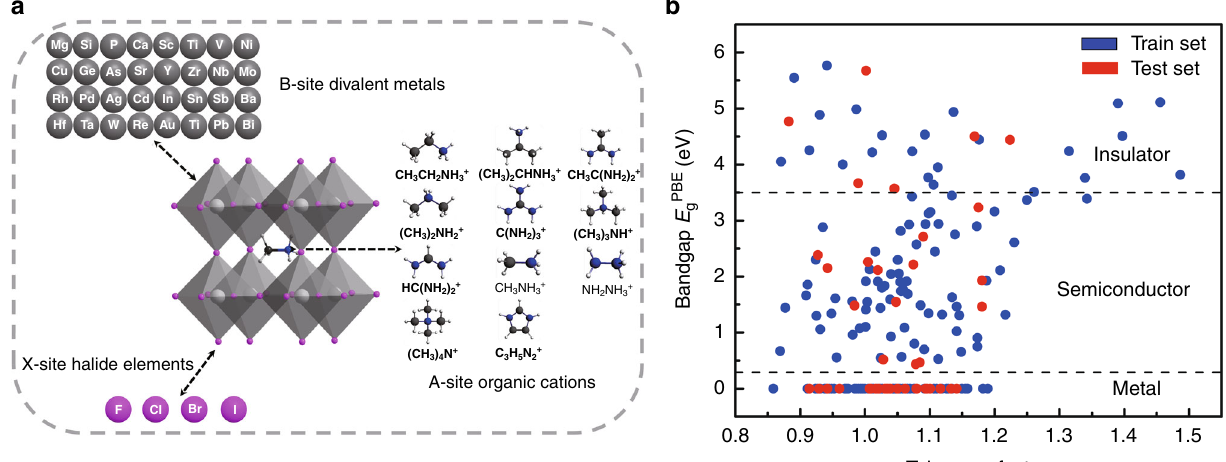
Fig. 2 HOIPs input dataset for training and testing. a 212 high throughput HOIP structures. The combination of 11 small organic molecular species (A-site) and 32 divalent metals (B-site) constitutes the input samples of our ML model. X is a typical halide. b Data visualization in training (blue dots) and test (red dots) of tolerance factor and bandgap E PBE of HOIPs. The entire dataset consists of metals, semiconductors, and g